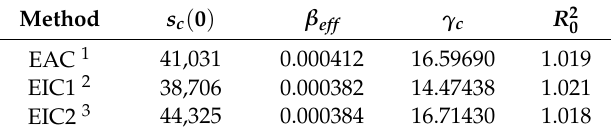
Table 6. Model parameter estimates for Tolima, Colombia (second outbreak).